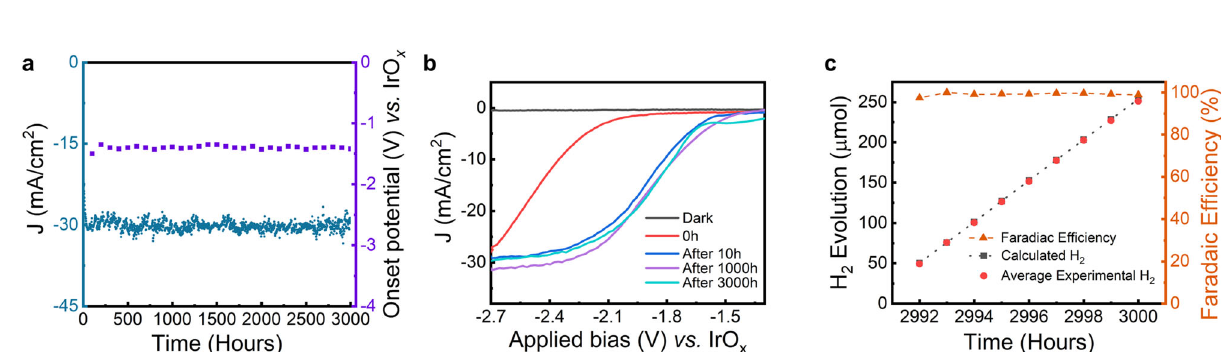
Fig.4|Two-electrodeultralongstabilityexperimentsofthe n + -GaNnanowires/ Si photocathode. a Chronoamperometry (CA) shows 3000h stability for the n + -GaN nanowires/Si photocathode at − 2.3V vs . IrO x under AM 1.5G one-sun illu- minationin0.5MH 2 SO 4 with0.2mM TritonX-100.The materialstabilityis further highlightedbythestabilityoftheonsetpotentialoverthecourseoftheCA. b Linear scanvoltammogramsofthephotocathodeat0h(redcurve),after10h(blue),after